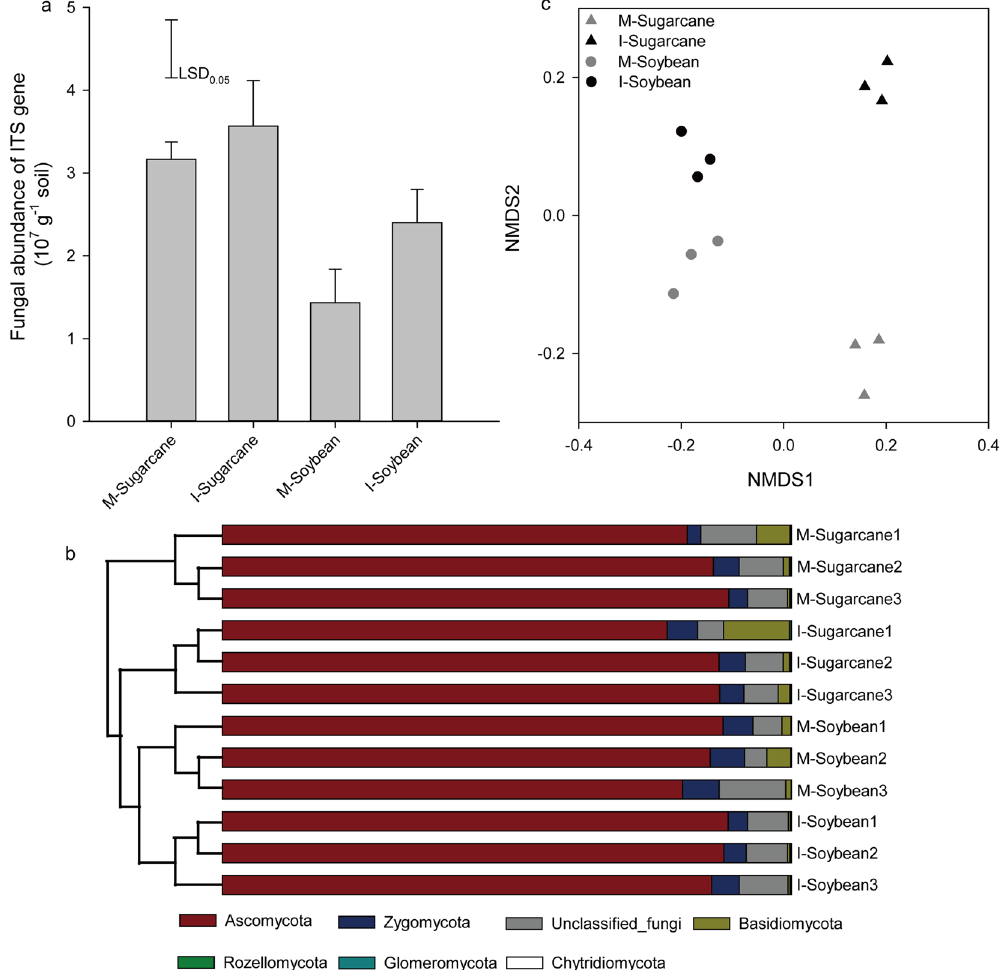
Figure 1. Comparison of the fungal communities in the soil on the basis of ITS gene analysis. ( a ) Fungal abundance was assessed using q-PCR, and data are the means and standard errors of 3 replicates. ( b ) Nonmetric multidimensional scaling (NMDS) plot of fungal communities in 12 soil samples under the three treatment regimes. ( c ) Phylogenetic relationships of fungal communities shown with the relative abundances of different fungal phyla. M-Sugarcane, sugarcane monoculture; I-Sugarcane, intercropped sugarcane. M-Soybean, soybean monoculture; I-Soybean, intercropped